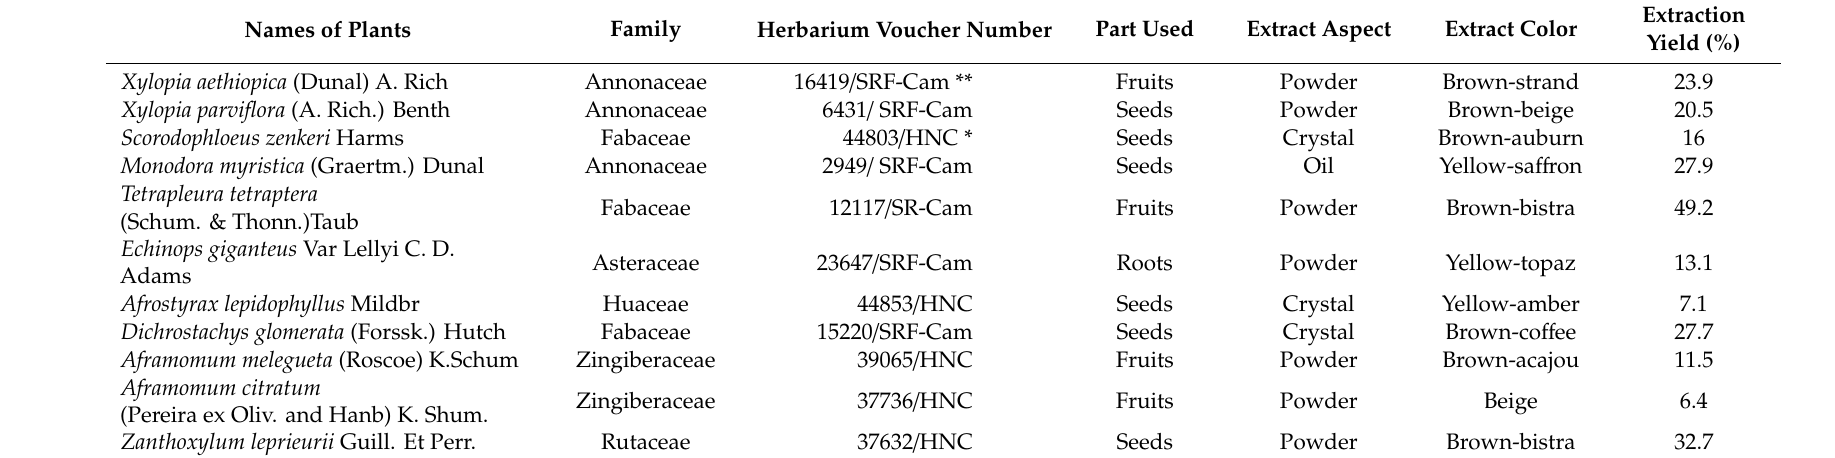
Table 1. Identification and yield of plant